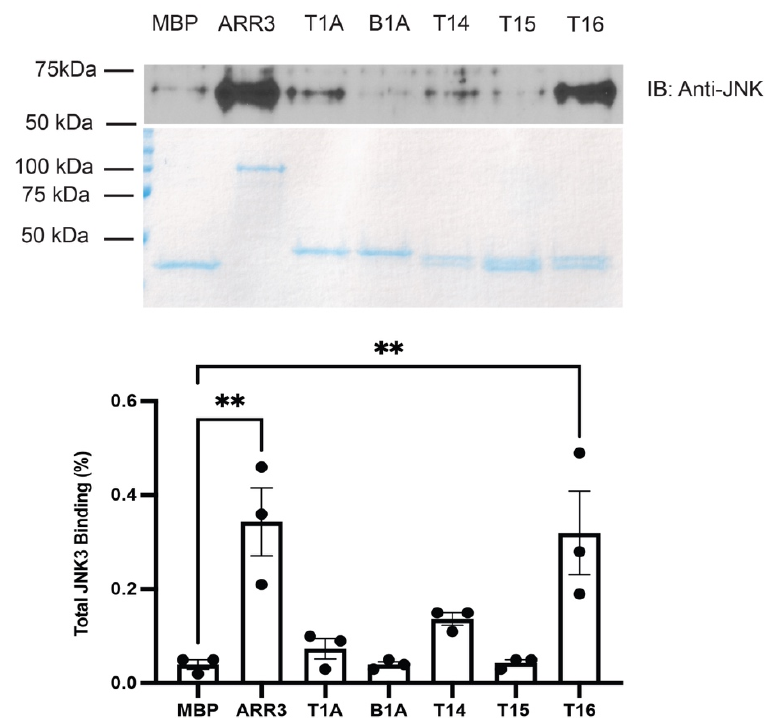
Figure 5. MBP pull-down of His-JNK3 α 2. Purified MBP fusions of indicated peptides and full-length arrestin-3 (10 μ g) were immobilized on amylose resin and incubated with purified His-JNK3 α 2 (5 μ g), as described in methods. The beads were washed, and bound proteins were eluted with 50 mM maltose. Aliquots of eluates were subjected to SDS-PAGE. The loading of MBP constructs was assessed by Coomassie staining (middle panel). JNK3 α 2 binding was measured by Western (top panel). Densitometric quantification (bottom panel) was performed using ImageJ software [26]. Dots represent measurements in individual experiments. Statistical analysis was performed using one-way ANOVA followed by Dunnett’s test with correction for multiple comparisons ( n = 3). **, p < 0.01 to MBP control. Part of these data (the first four columns) was previously published in [21].